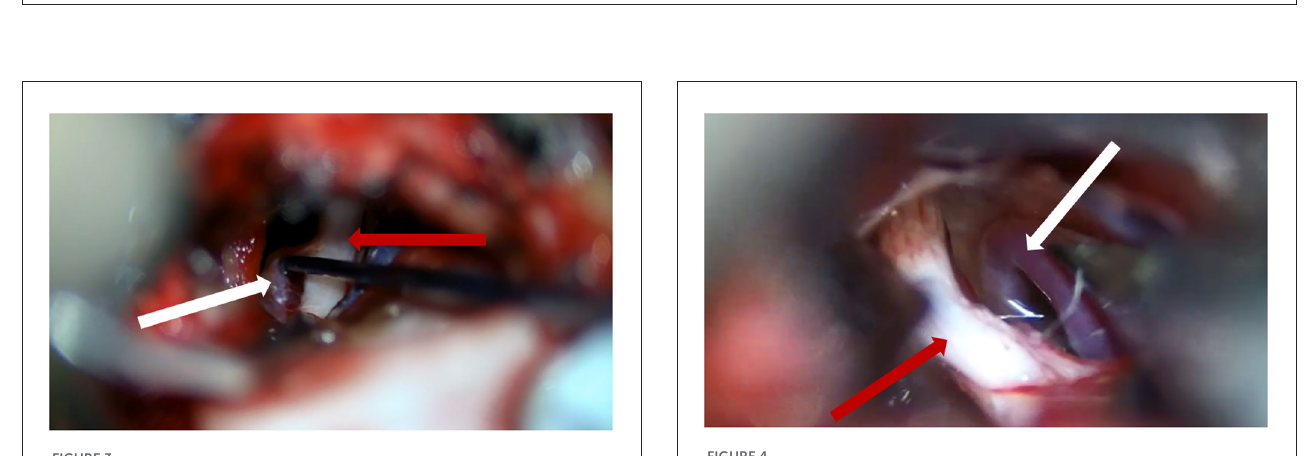
FIGURE3 Teflon sponges (white arrow) separate small blood vessels away from the trigeminal nerve (red arrow).